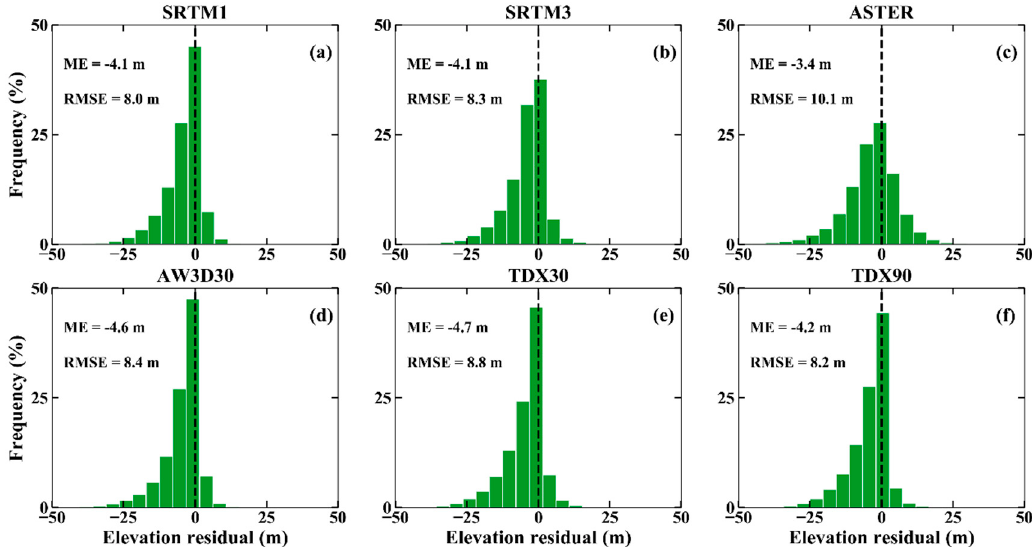
Figure 2. Histogram plot of the elevation errors (ICESat-2 minus different digital elevation models (DEMs)) for ( a ) SRTM1; ( b ) SRTM3; ( c ) ASTER; ( d ) AW3D30; ( e ) TDX30 and ( f ) TDX90. (TDX30: 30-m TDX DEM, TDX90: 90-m TDX DEM).